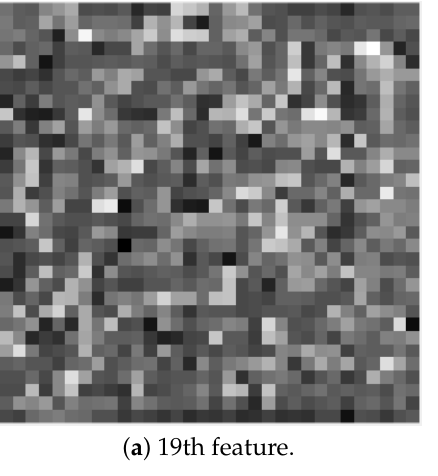
( a ) 19th feature. ( b ) Normalized histogram and Laplacian fitting.